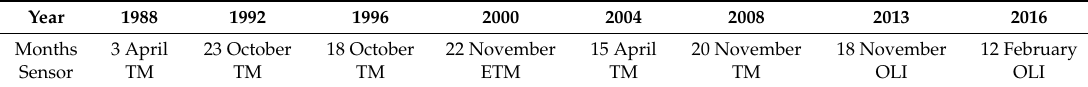
Table 1. Dates of the Landsat Time series 5, 7, and 8 images (Landsat 5, hereafter Thematic Mapper (TM); Landsat 7, hereafter Enhanced Thematic Mapper Plus (ETM+); and Landsat 8, hereafter Operational Land Image